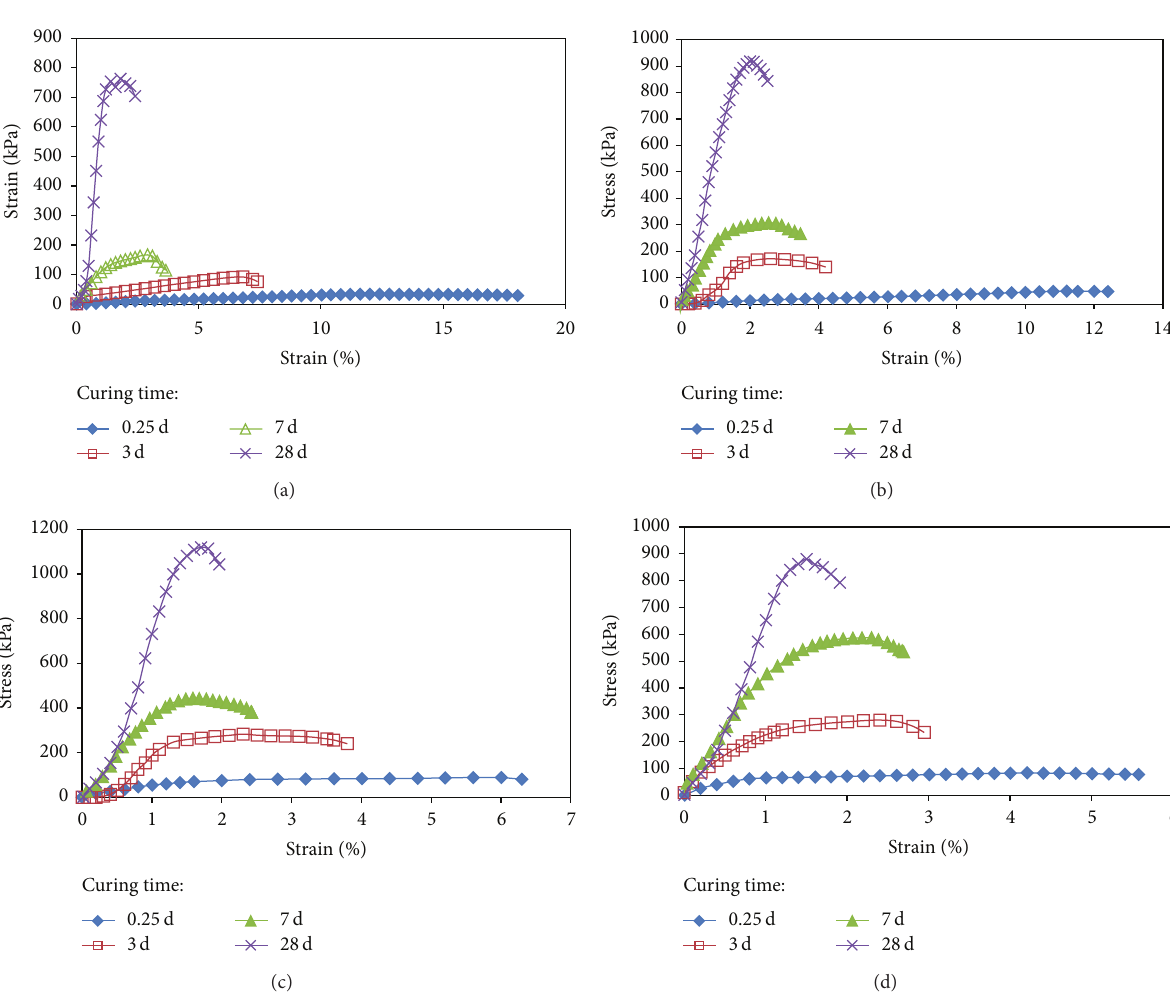
Figure 4: Effect of curing time on the stress-strain curve of CPB at different initial temperature: (a) 2, (b) 20, (c) 35, and (d) 50 ∘ C.